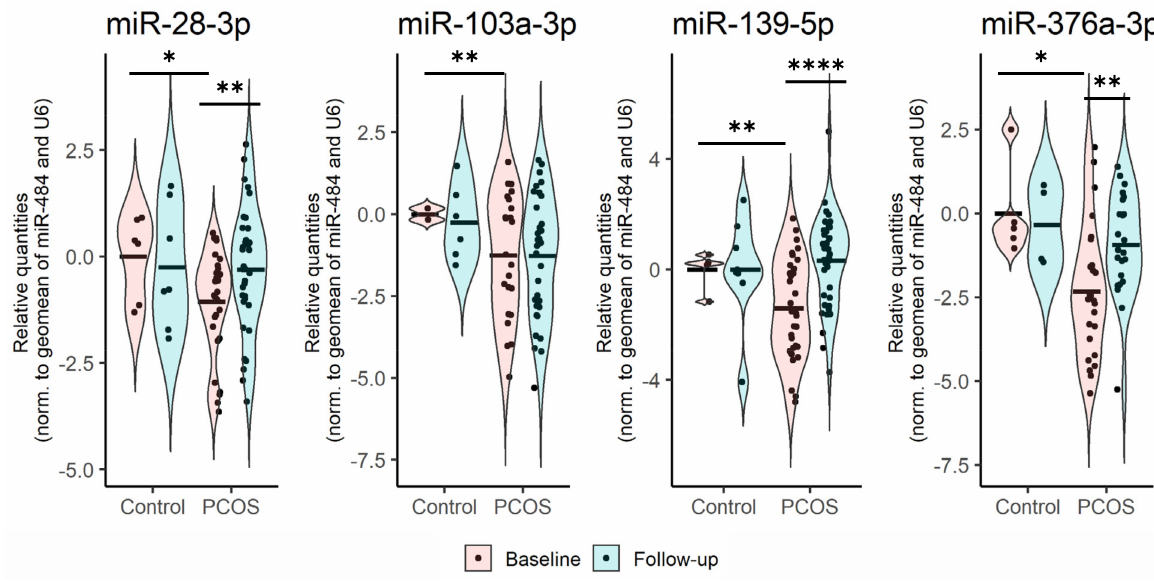
Figure 2. Relative expression of miRNAs which were significantly different at BL between healthy controls and women with PCOS. Levels of the individual miRNAs were normalized against the geo- metric mean of miR-484 and U6. The comparison of BL or FU levels was made with an independent student t -test, while a paired t -test was used for comparing BL vs. FU levels. *: p < 0.05, **: p < 0.001, **** p <